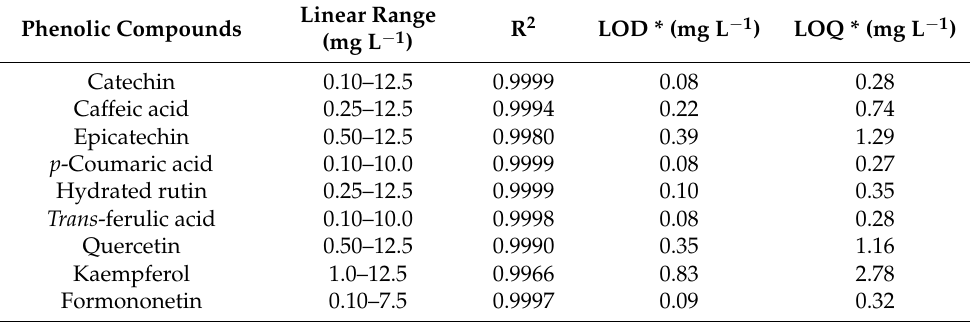
Table 1. Figures of merit obtained for the analysis of phenolic compounds in craft beers.